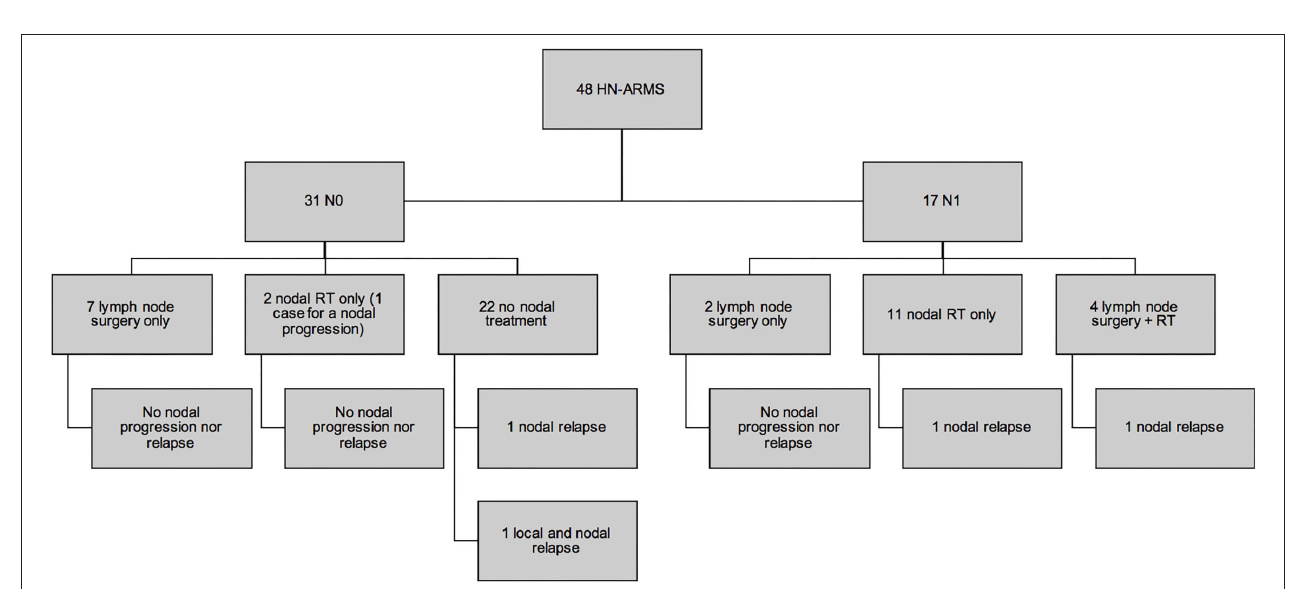
FIGURE 4 | Local control according to the local treatments (surgery and radiation therapy).